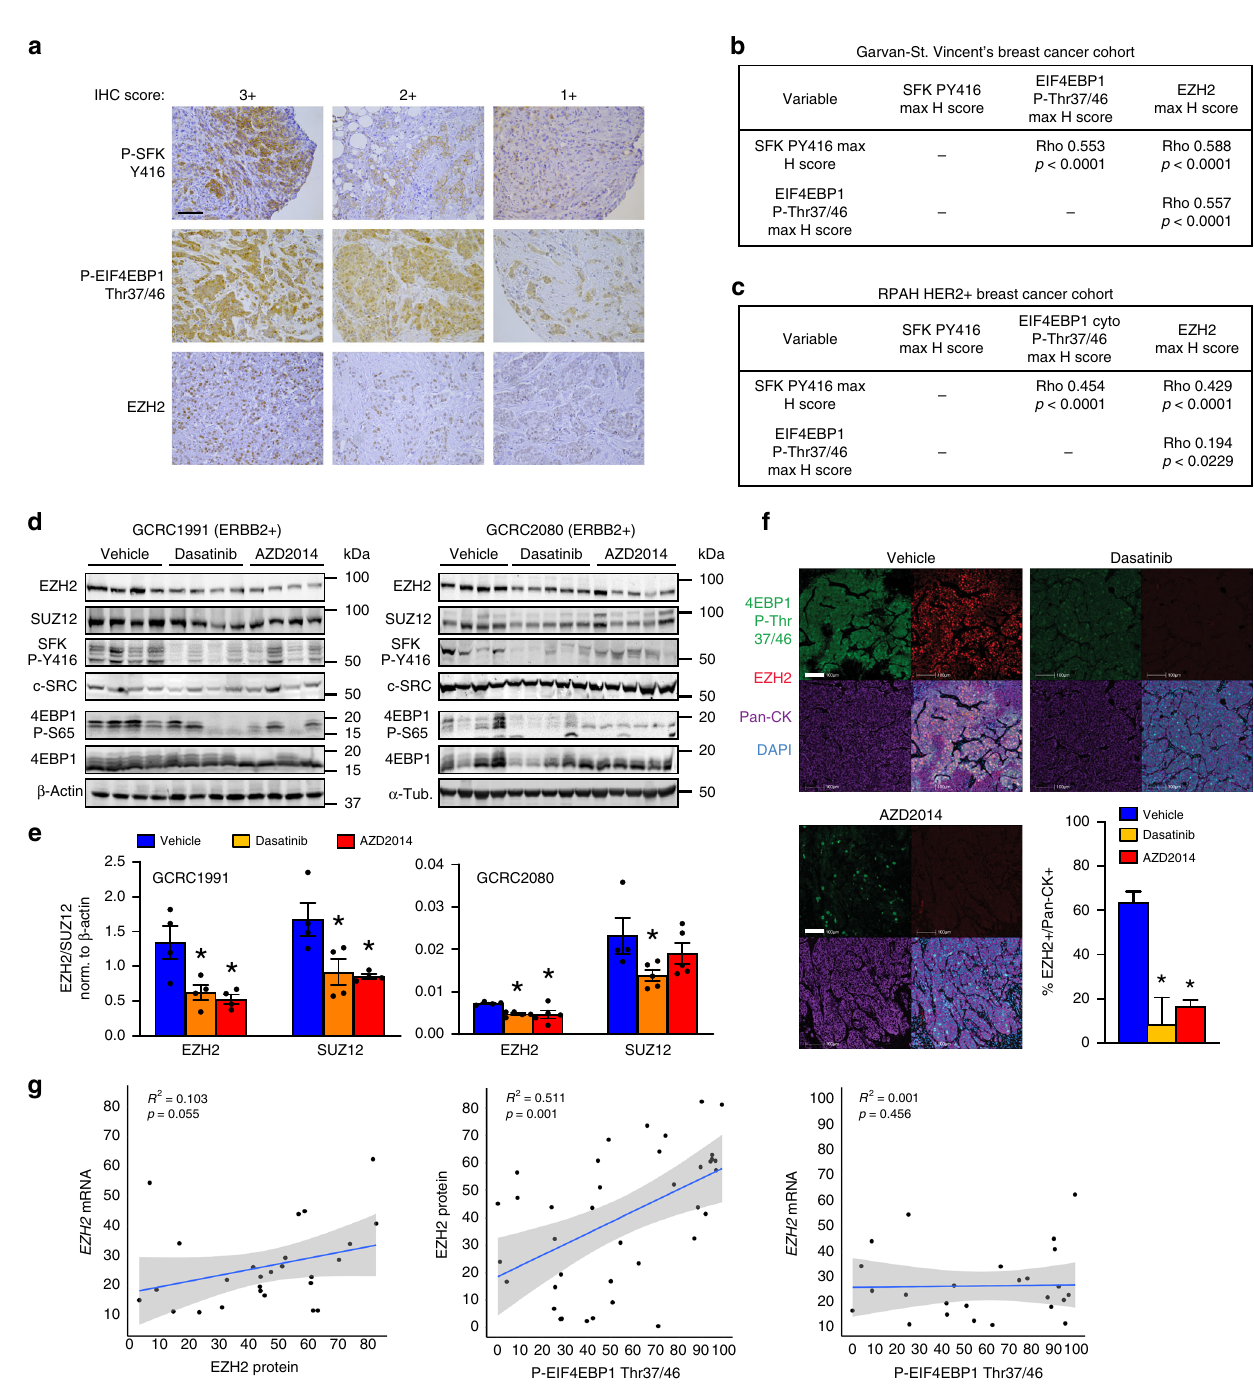
c-Src Drives PRC2 overexpression by regulating bioenergetics . c-Src can cooperate with RTKs to activate Ras-MAPK and PI3K- Akt pathways that act upstream of mTORC1 15,33,34 . However, phosphorylation of ErbB2, Egfr, ErbB3, Erk, and Akt was unaf- fected by c-Src ablation in ErbB2 + tumors, as was Akt-dependent phosphorylation of Tuberous Sclerosis Complex 2 (Tsc2) (Sup- plementary Fig. 6a). Thus, in ErbB2-driven breast cancer, c-Src appears to activate mTORC1 via a mechanism independent of canonical RTK-driven pathways. Because mTORC1 is modulated by metabolic inputs 35 and c-Src is implicated in metabolic regulation 36,37 , we examined known metabolic regulators of mTORC1, including energy and amino acid levels. Strikingly,